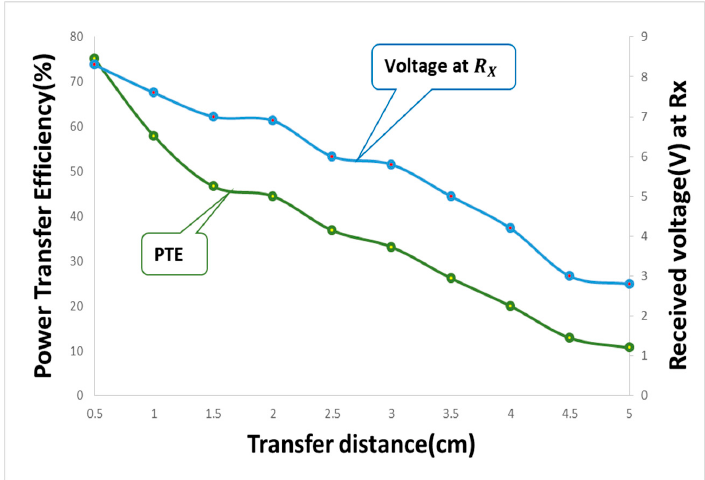
Figure 21. Power transfer efficiency (%) between the two coils and the received voltage (V) in the receiver coil ( R X ) as a function of the transfer distance (cm).